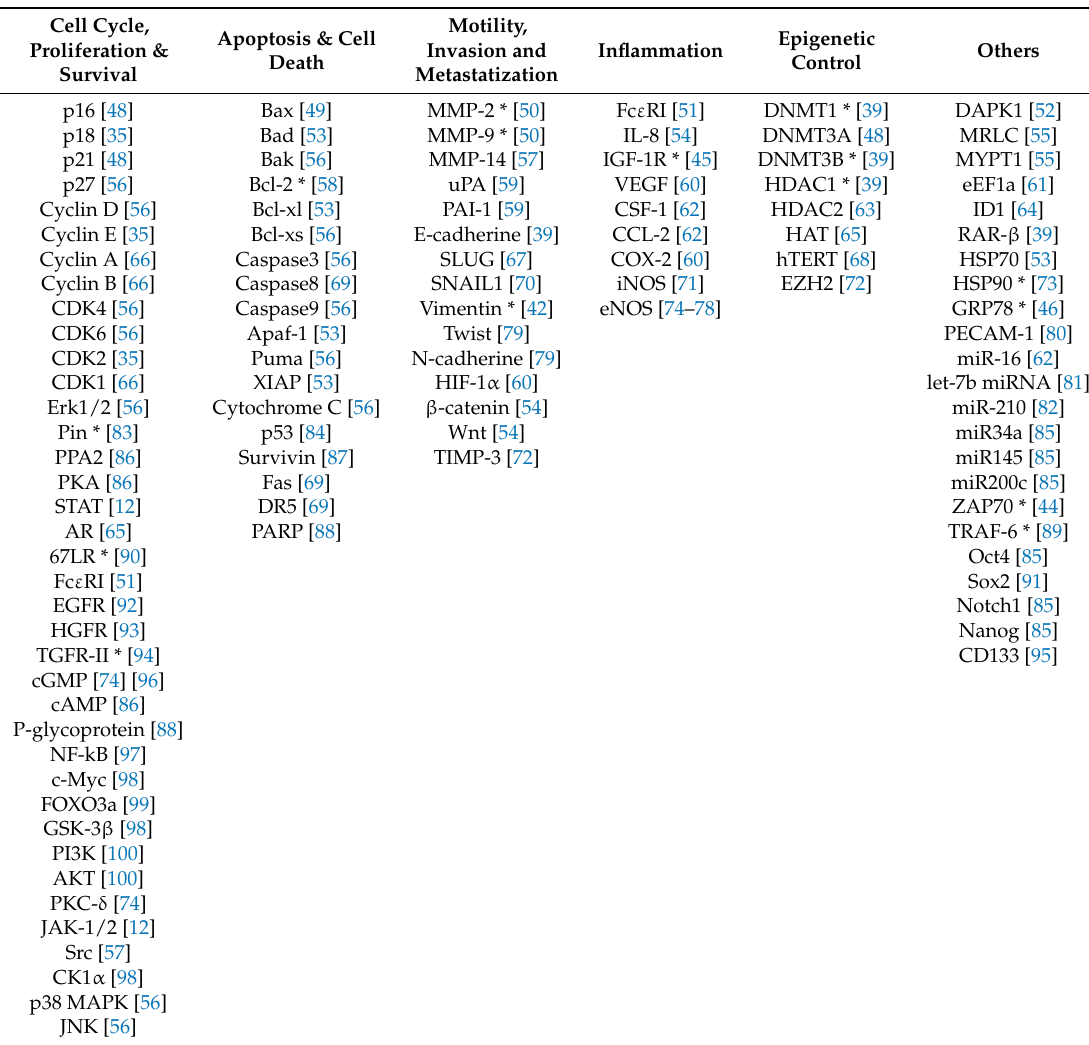
Table 1. Epigallocatechin-gallate (EGCG) molecular targets that are involved in cancer onset and